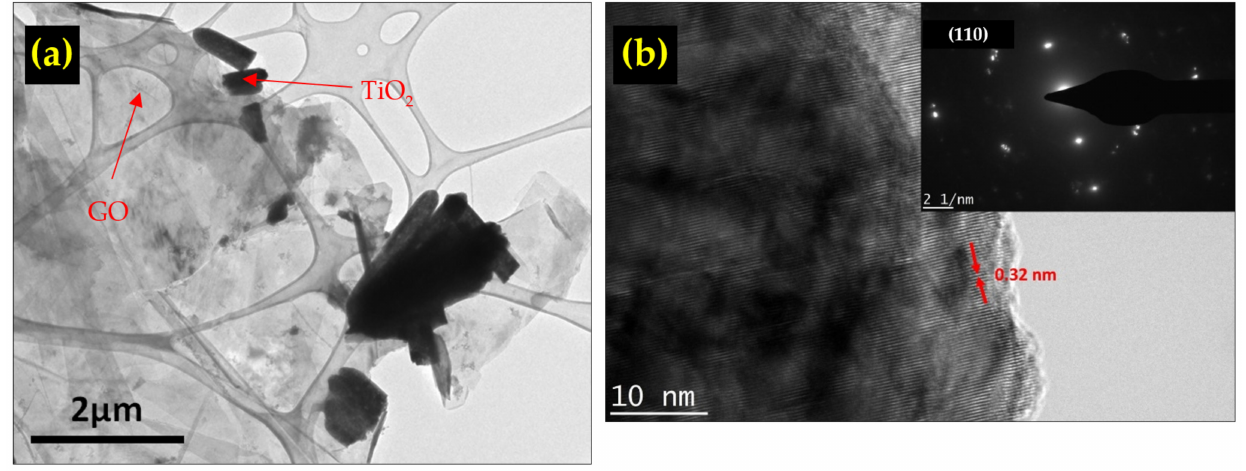
Figure 9. ( a ) TEM image of the TiO 2 /rGO composite, ( b ) SAED of TiO 2 /rGO. The XPS survey scan spectra of the TiO 2 and TiO 2 /rGO sample is presented in Figure 10a. Both samples showed the presence of C 1s, Ti 2p, Ti 2s, and O 1s peaks, with the TiO 2 /rGO sample showing a higher intensity C 1s peak, due to the presence of rGO on the TiO 2 nanoflower surface. The narrow scan of Ti 2p in Figure 10b,c reveals two prominent peaks at the binding energies of 459 eV and 464 eV corresponding to Ti 2p 3/2 and Ti 2p 1/2 , respectively, which arises from spin-orbit splitting. A shoulder peak at 460 eV is noticeable in the TiO 2 /rGO sample, which suggested the presence of Ti 3+ species [62,63]. This species is often considered responsible for the adsorption of water molecules by providing ample active sites [64]. Figure 10d reveals the narrow scan of C 1s. The deconvolution of the spectra reveals 5 peaks that can be assigned to carbon from C=C sp 2 , C-C sp 3 , C-O, C=O, and O-C=O bonds. Finally, Figure 10e,f show the core level scan O 1s of TiO 2 and TiO 2 /rGO, respectively. The main peak at 530 eV is attributed to the lattice oxygen. For the TiO 2 /rGO sample, a peak is also observed at 530.7 eV, which corresponds to the oxygen vacancy [65]. Both samples also displayed a peak at 532.1 eV corresponding to chemisorbed oxygen [64]. It is reported that this oxygen species could play a part in the redox reaction on the surface of the material.